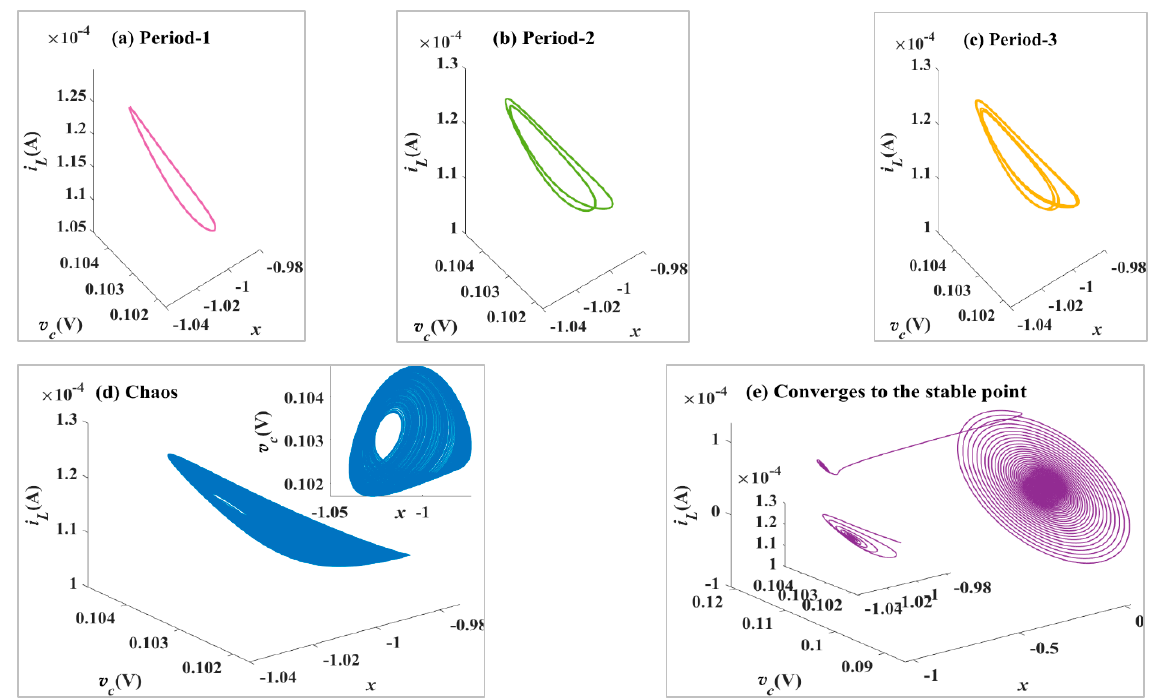
Figure 24. Typical phase diagrams. ( a ) C = 21.5 μ F, L = 0.9 H; ( b ) C = 24 μ F, L = 0.94 H; ( c ) C = 23.5 μ F, L = 0.96 H; ( d ) C = 24 μ F, L = 0.98 H; ( e ) C = 26 μ F, L = 0.98 H.